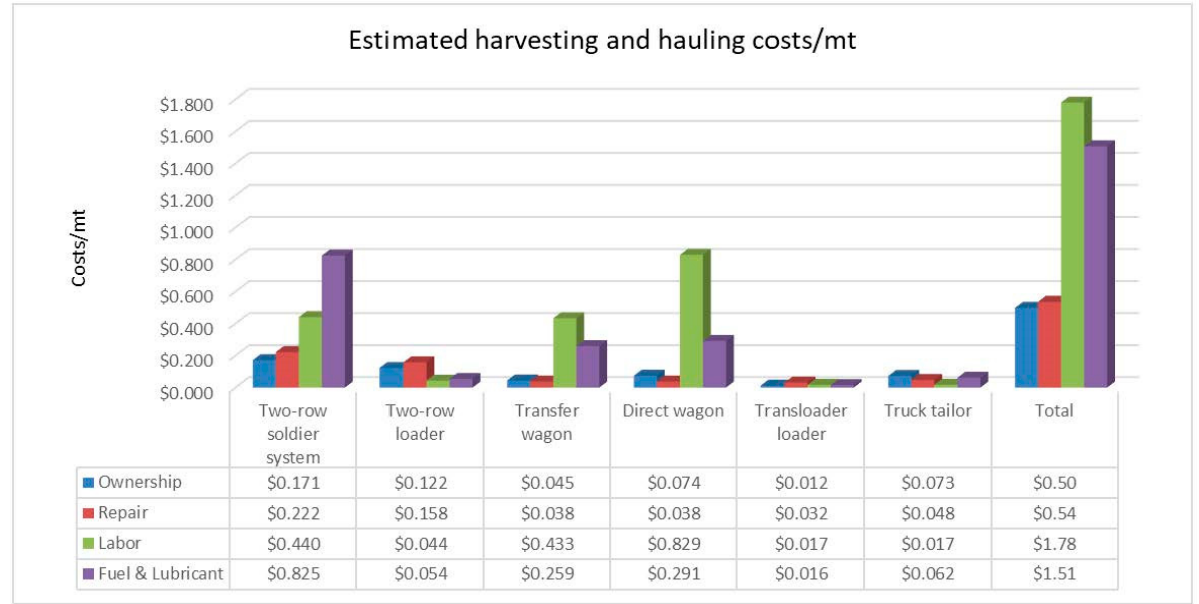
Figure 2. Summary of costs to operate a harvesting and hauling unit/year of energycane.